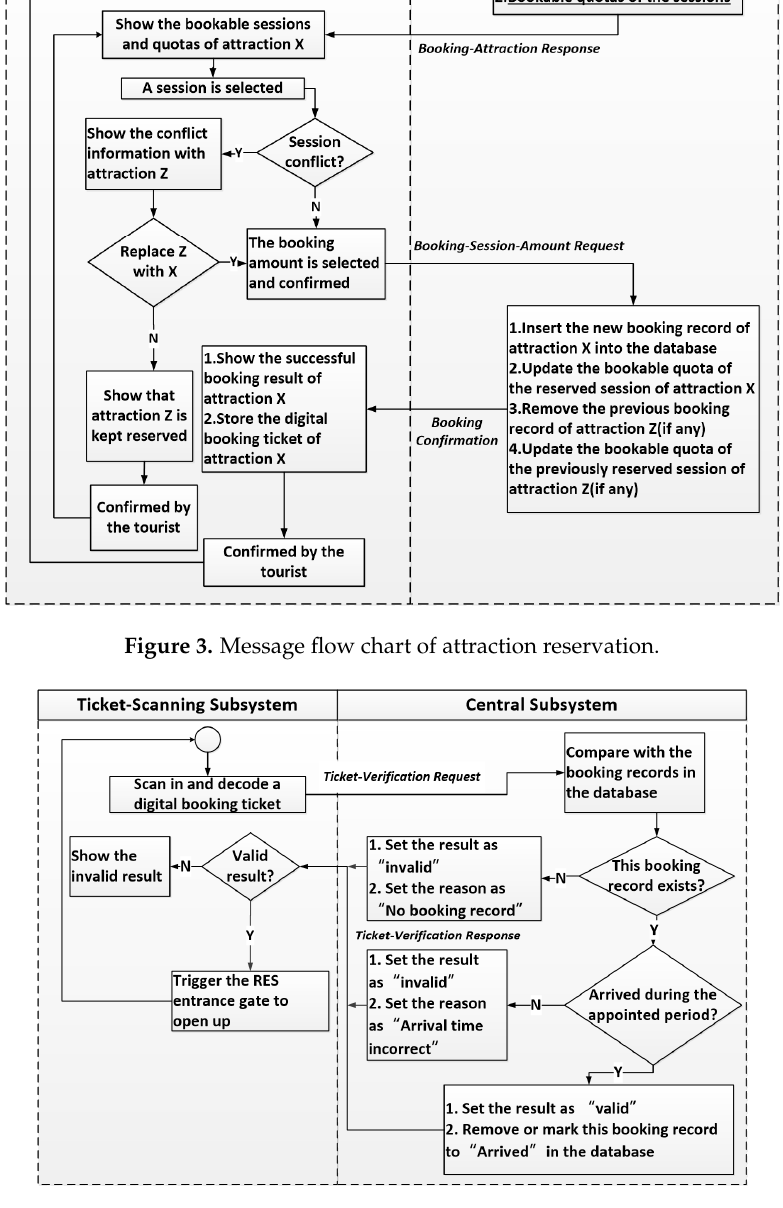
Figure 4. Message flow chart of verification of a booking ticket.